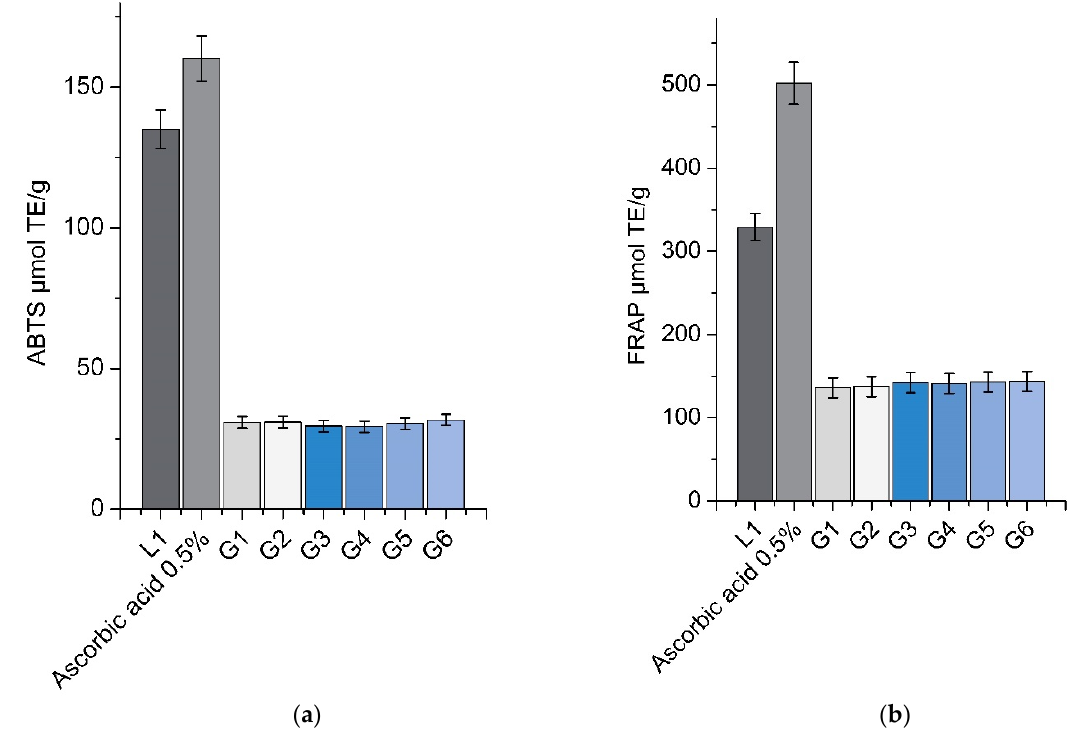
Figure 8. Antioxidant activity detected in in situ gels G1–G6 and lyophilized 1% aqueous solution of balsam poplar buds extract (L1) by ( a ) the ABTS method; and ( b ) the FRAP method (mean ± SD, n = 3).